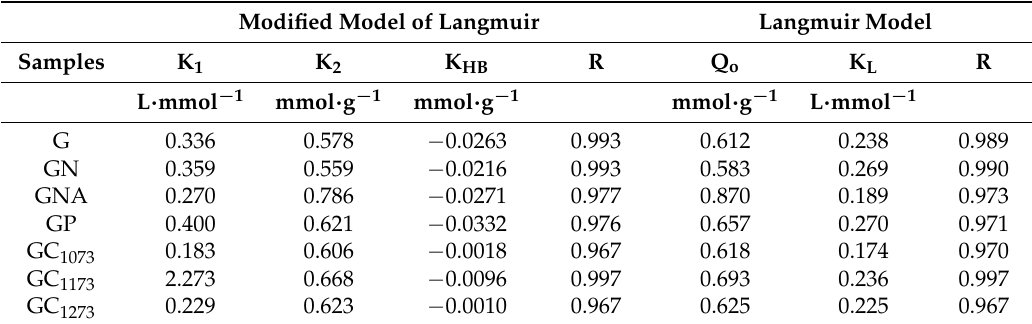
Table 2. Setting parameters to the Langmuir and Langmuir models modified for the adsorption of phenol from aqueous solution for the process of adsorption of 2